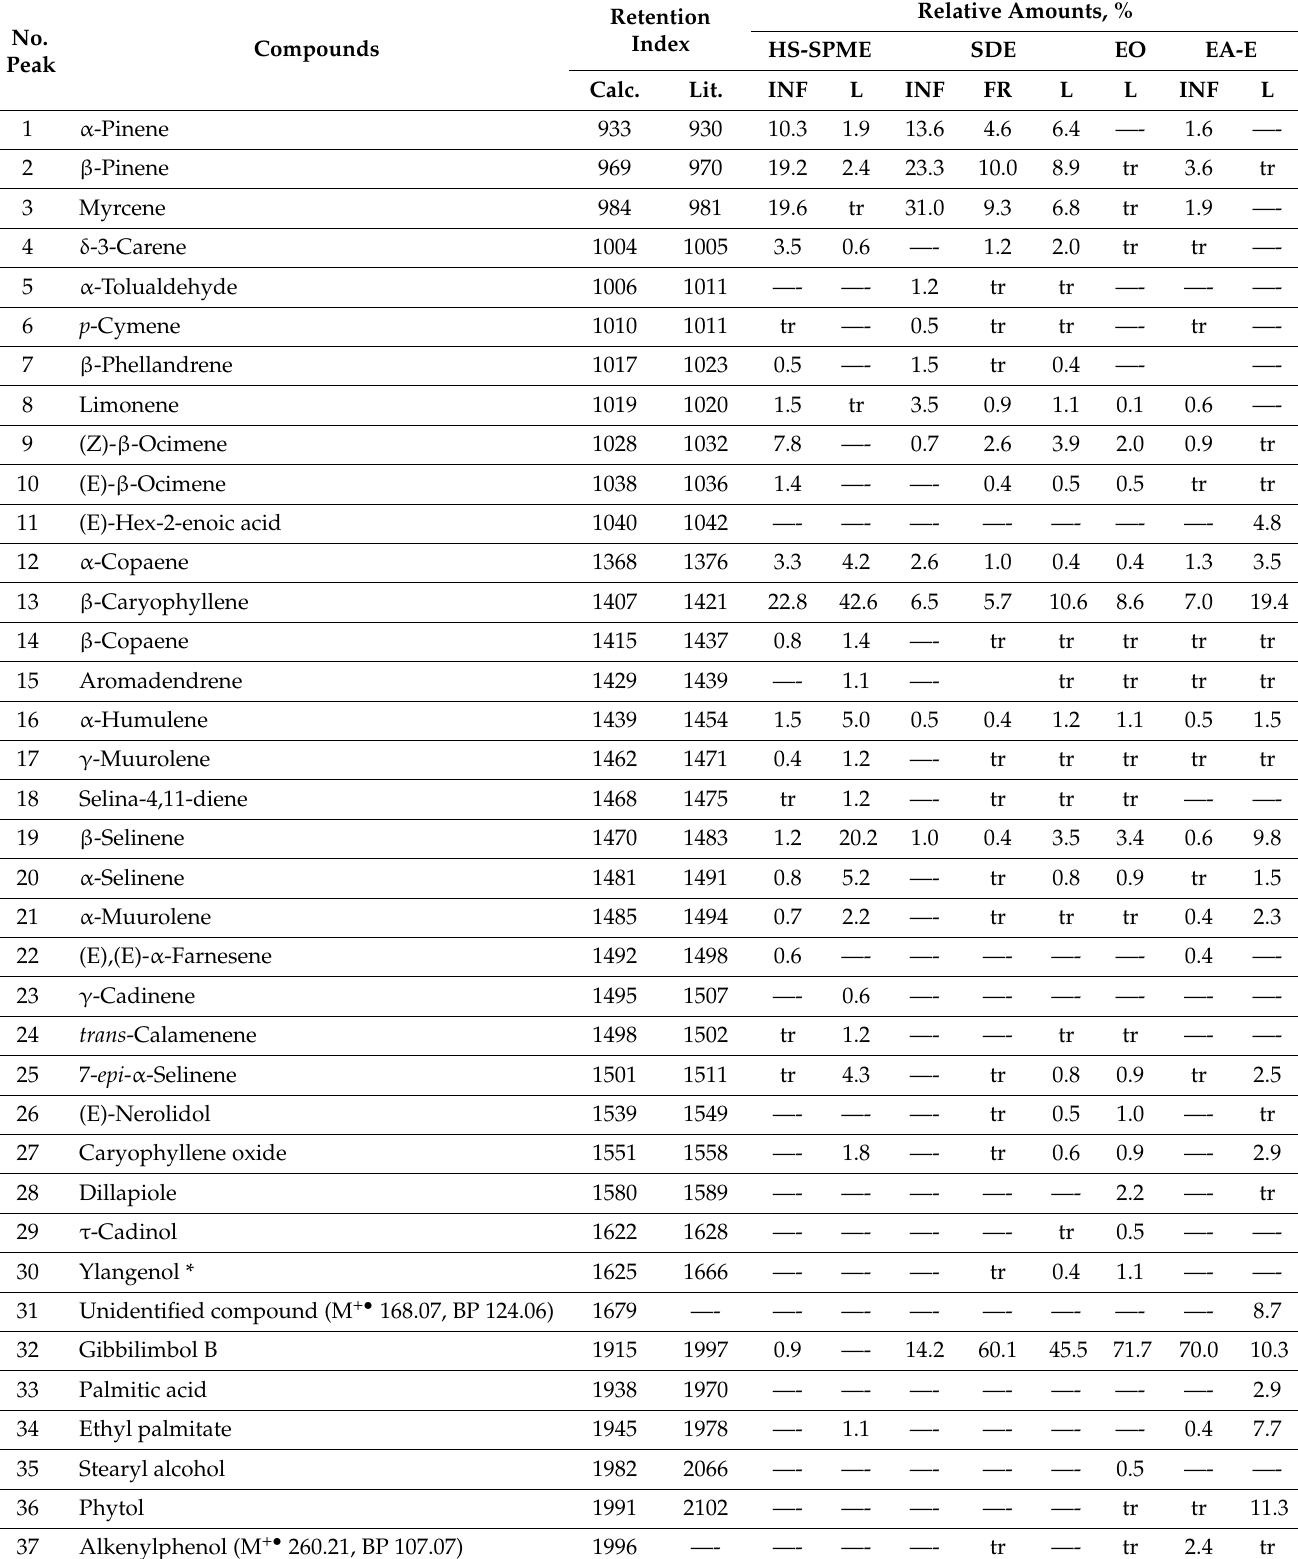
Table 1. Chemical composition of volatile fractions (HS-SPME/SDE), essential oil (MWHD) and ethyl acetate extracts (EA-E) of different parts from Piper eriopodon